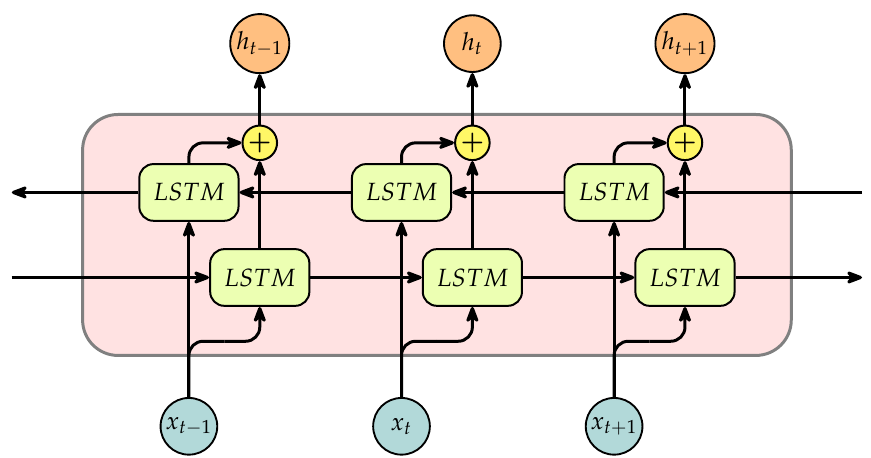
Figure 4. Workflow for simple BiLSTM model.